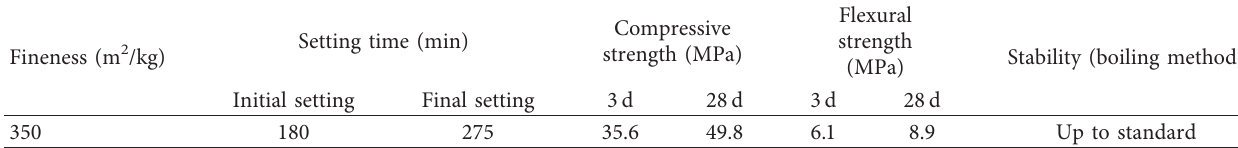
Table 2: Cement performance.